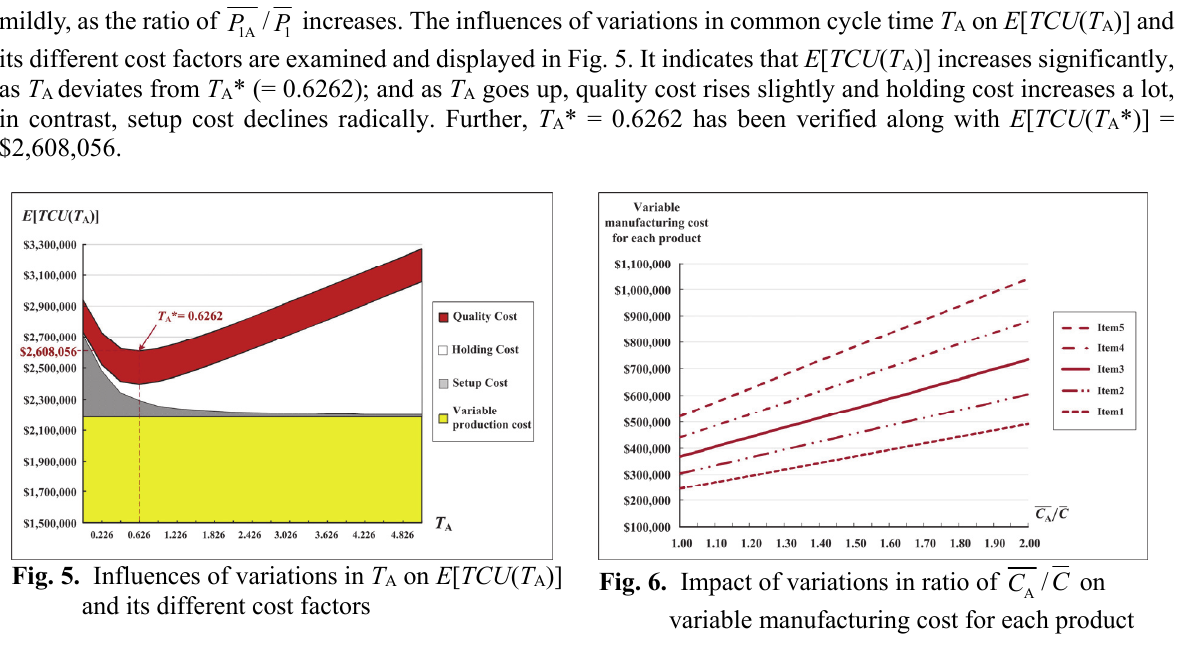
Fig. 6. Impact of variations in ratio of variable manufacturing cost for each product